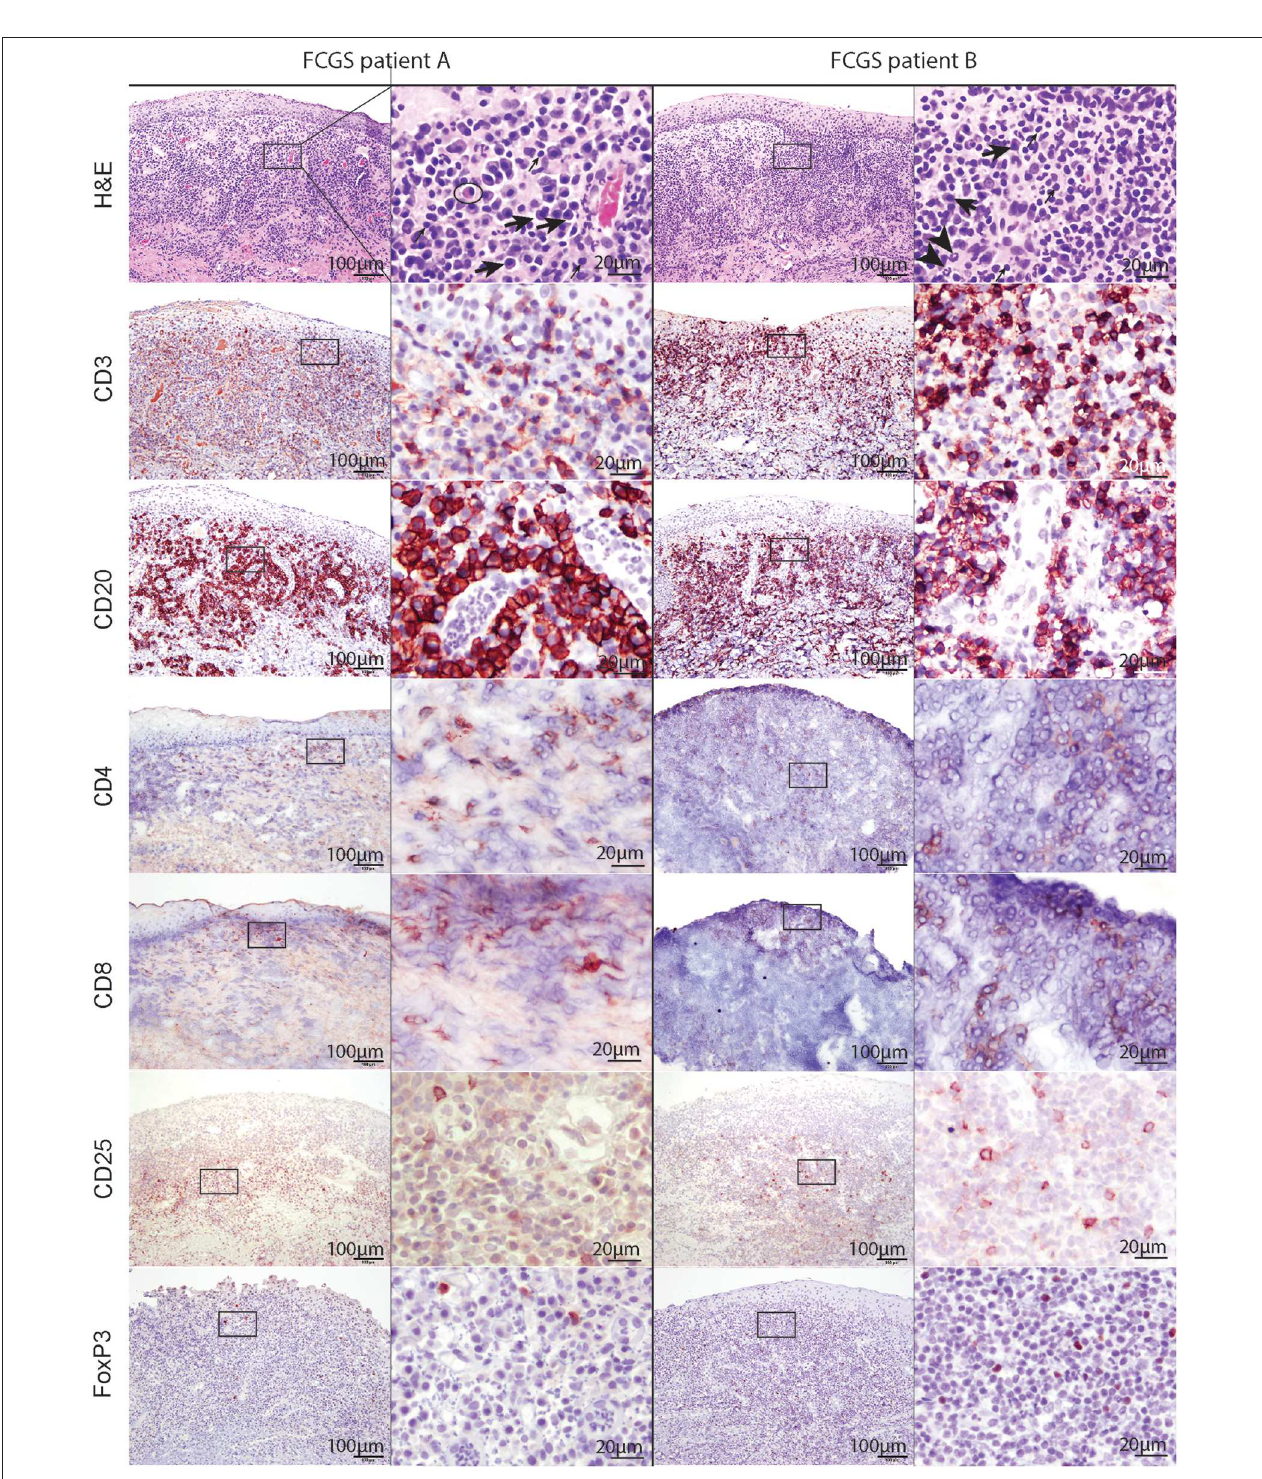
FIGURE 2 | Low (100x) and high (400x) magnification images of hematoxylin and eosin and immunohistochemical sections from two different FCGS patients. The rectangle on low magnification image indicates the area captured on high magnification. Note the abundance of plasma cells (thick arrow) and occasional mott cells (ellipse) in the sections of feline patients relative to a fewer lymphocytes (thin arrow) and neutrophils (arrow head). Mott cell is a plasma cell which cytoplasm is expanded by accumulation of immunoglobulins. Scale bar = 100 µ m on low (100x) magnification captures and 20 µ m on high (400x) magnification captures.